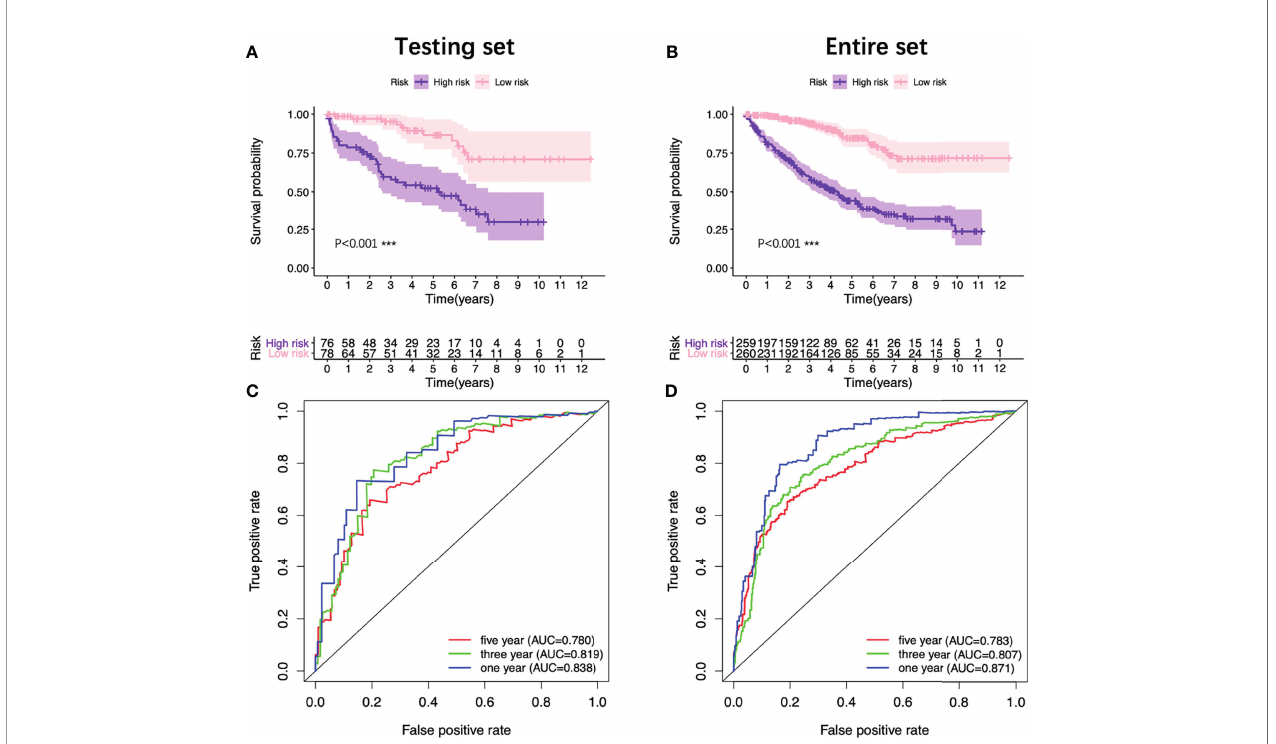
FIGURE 8 | Validation of the nomogram. K-M survival analysis of the nomogram in the testing set (A) and the entire set (B) . ROC curves of the nomogram in the testing set (C) and the entire set (D) . K-M, Kaplan – Meier; ROC, receiver operating